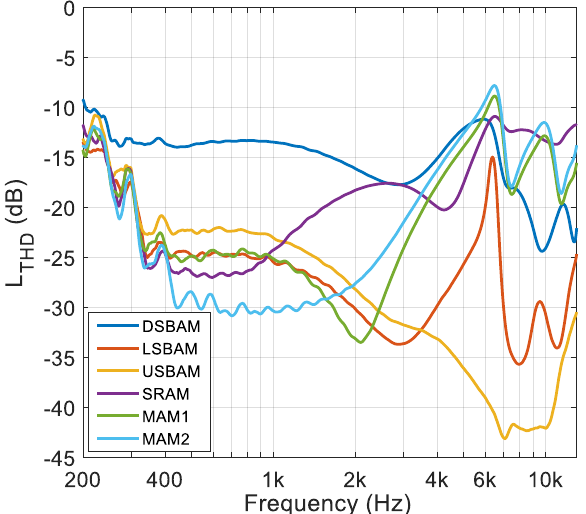
Figure 6. Comparison of 𝐿 𝑇𝐻𝐷 levels for each modulation technique (modulation index m = 1).